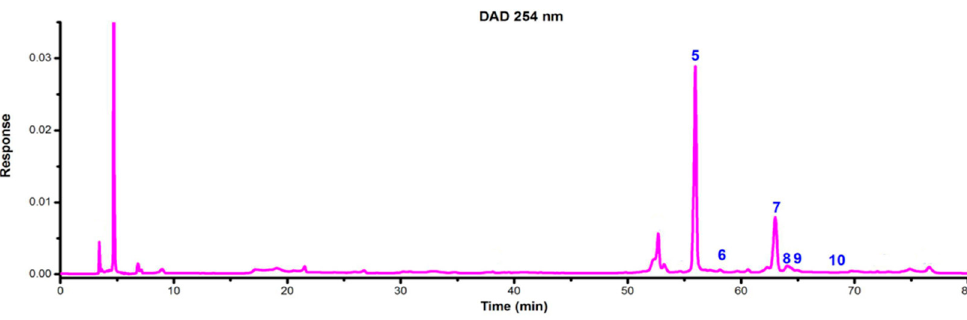
Figure 12. DAD (254 nm) chromatograms of flavonoid extract from M. polymorpha L. archegoniophore.